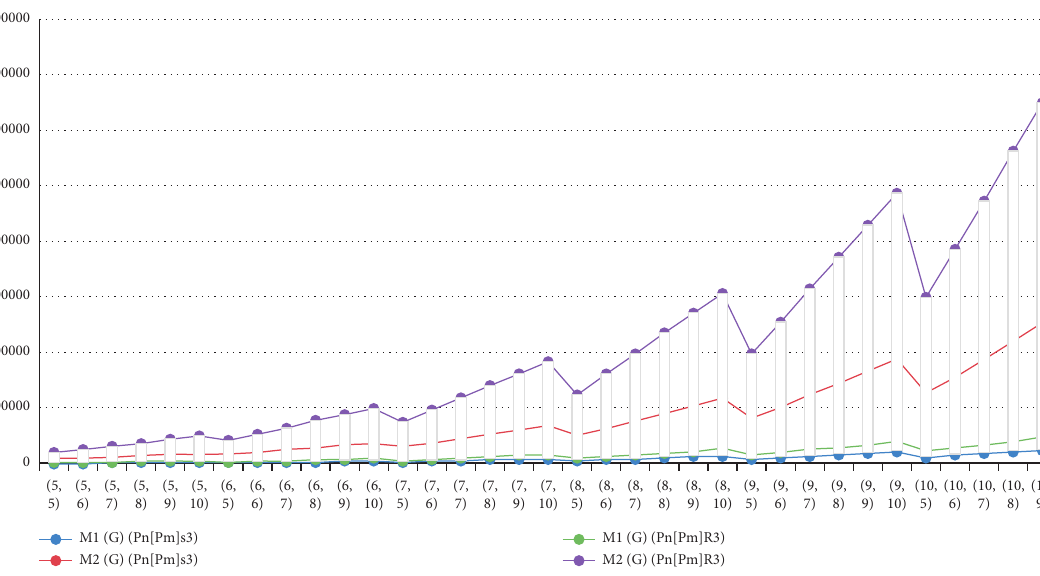
Figure 7: Numerical comparison of Zagreb indices of generalized subdivision and semitotal point operations with lexicographic product of the networks for k � 3.